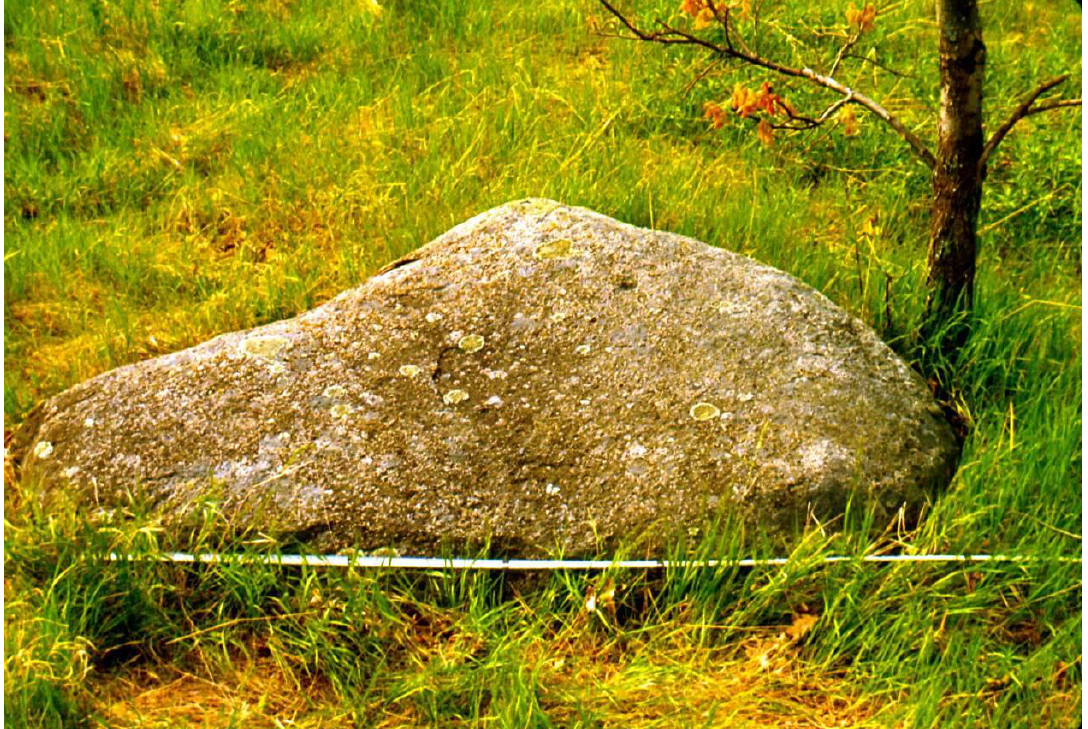
Figure 9. The Starman bison-shaped headstone aligned to face the summer solstice sunrise (see Figure 2). It has been worked to achieve the bison profile including the hump, head and straight, flat back end (Figure 2). It is over 2m long and 1.7m high to the tip of the hump. Extremely weathered red granite, the rock would have been bright red in colour when first